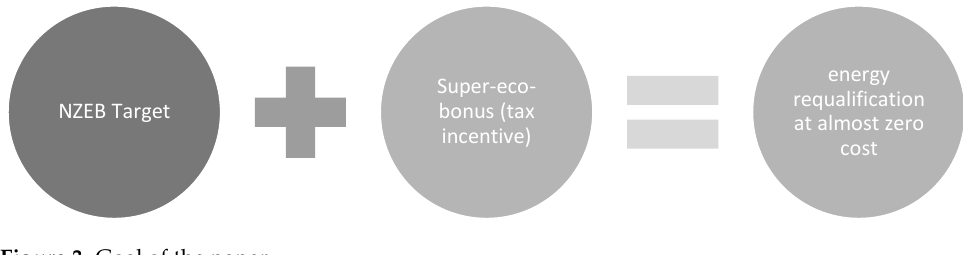
Figure 3. Goal of the paper.